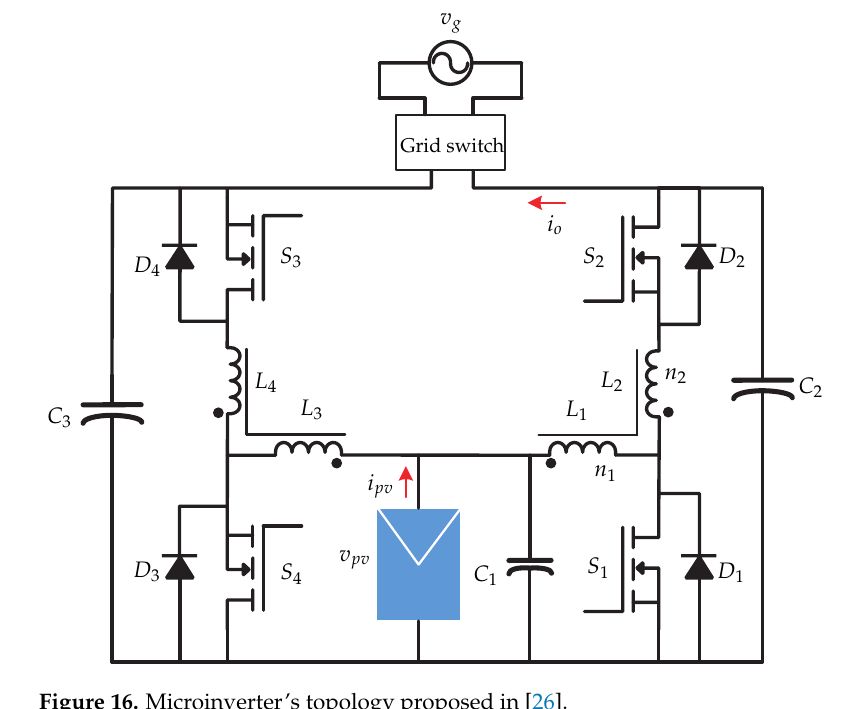
Figure 16. Microinverter’s topology proposed in [26].